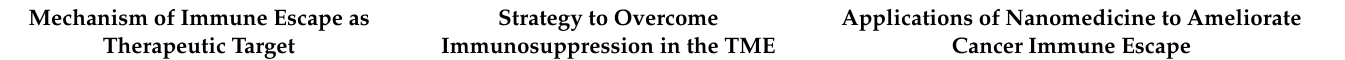
Table 1. Current applications of nanomedicine to overcome immunosuppression in the TME in patients with breast